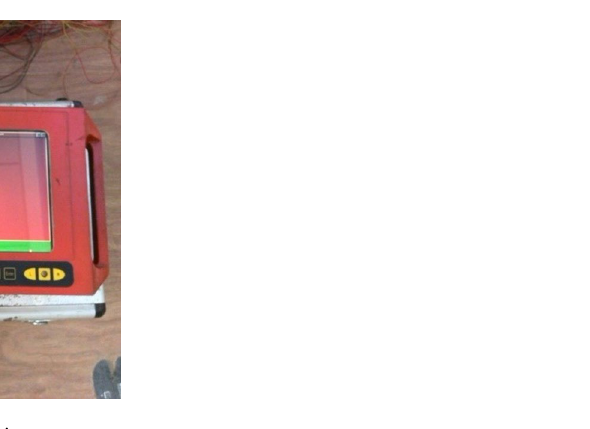
Figure 3. Se2432 parallel electric method